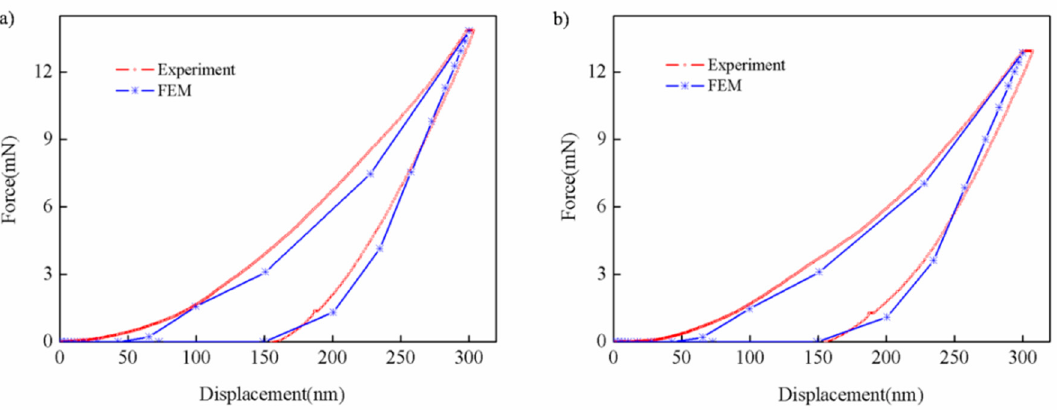
Figure 5. Comparison of experimental curves and finite element predictions for various temperatures: ( a ) room temperature; ( b ) high temperature.